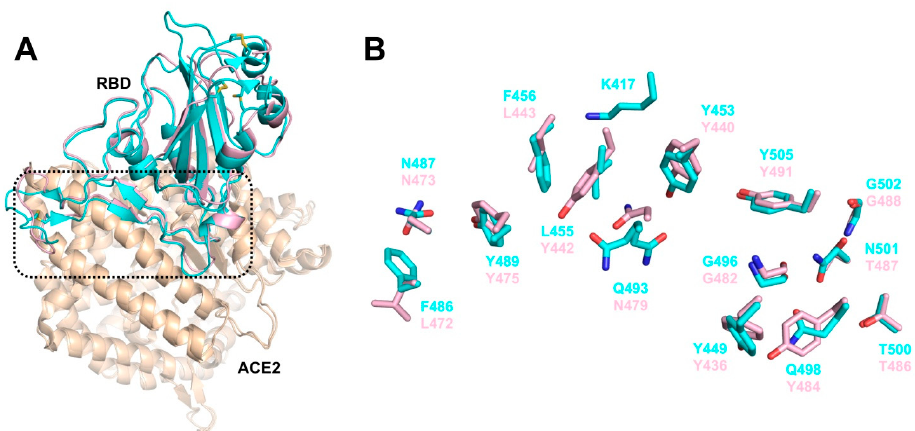
Figure 3. Structural details of the interface between SARS-CoV and SARS-CoV-2 RBDs and ACE2. ( A ) Structural overlay of SARS-CoV-2 (cyan, PDB ID: 6M0J) and SARS-CoV (light pink, PDB ID: 2AJF) RBDs bound to ACE2 (wheat), displayed as cartoon. The four disulfide bonds in SARS-CoV-2 RBD are shown as sticks. The region enclosed by the black dashed lines, encompassing the interface between RBD and ACE2 is illustrated in detail in panel ( B ). Overlay of the RBD interface residues of SARS-CoV-2 (cyan sticks) and SARS-CoV (light pink sticks). Q493 is shown in two alternate positions.